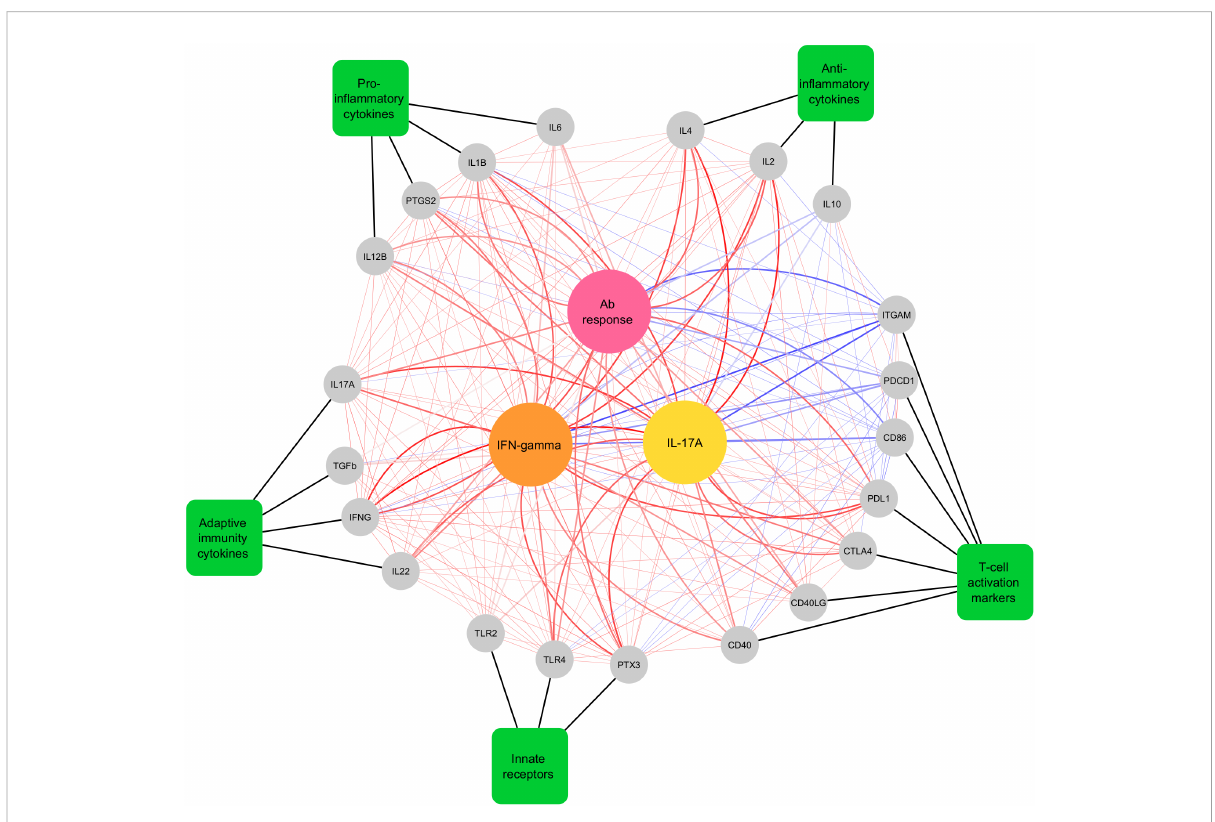
FIGURE 4 Network plot showing Pearson correlations and canonical correlations between differentially expressed genes, antibody levels and T cell- mediated cytokine responses in cattle vaccinated with rMAP fusion protein at weeks 0, 6, 9 and 12. Genes are displayed as grey circles, gene categories are displayed as green rectangles and the three central circles colored pink, yellow and orange are, antibody, IL-17A (pg/mL), and IFN- g (pg/mL) responses to RA, respectively. Thick black lines indicate the functional group that the genes belong to. Thick red and blue lines indicate canonical correlations above |0.6| and thin red lines indicate signi fi cant (P < 0.05) Pearson correlations between genes. Red lines indicate positive associations and correlations, while blue lines indicate negative associations and correlations. Darker line colors indicate stronger associations and